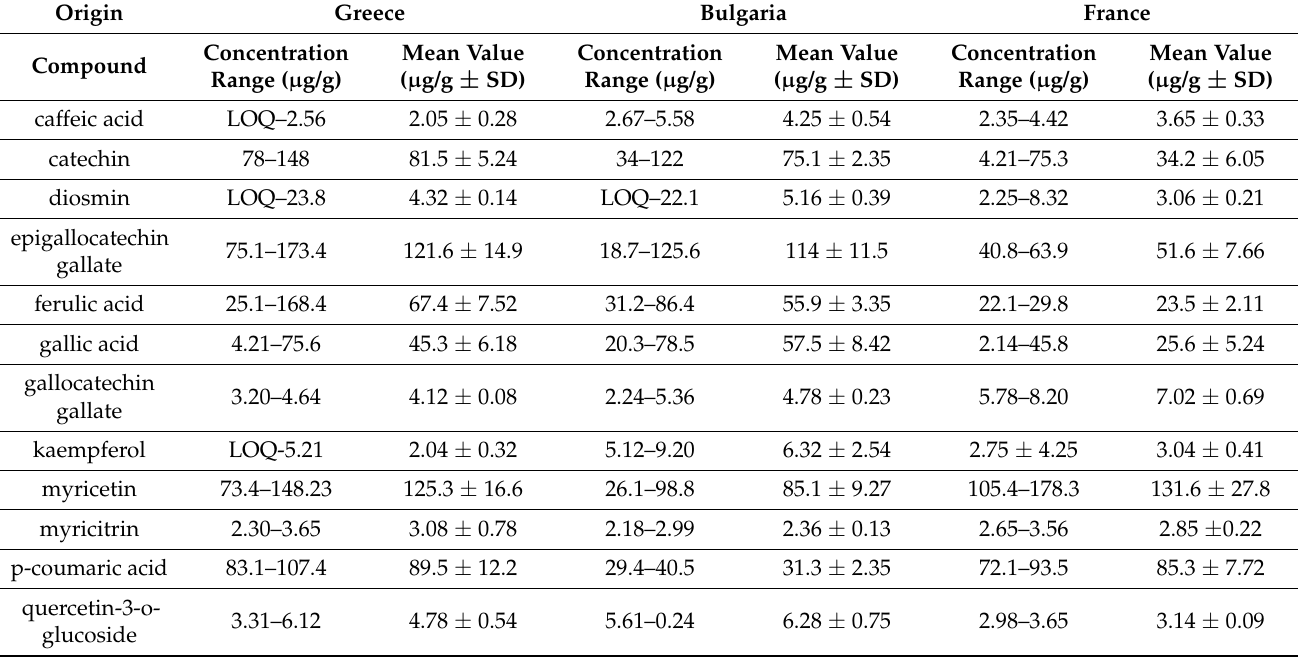
Table 5. Quantification results of the phenolic compounds determined in walnuts originating from Greece, Bulgaria, and France (samples analyzed in triplicate, n =